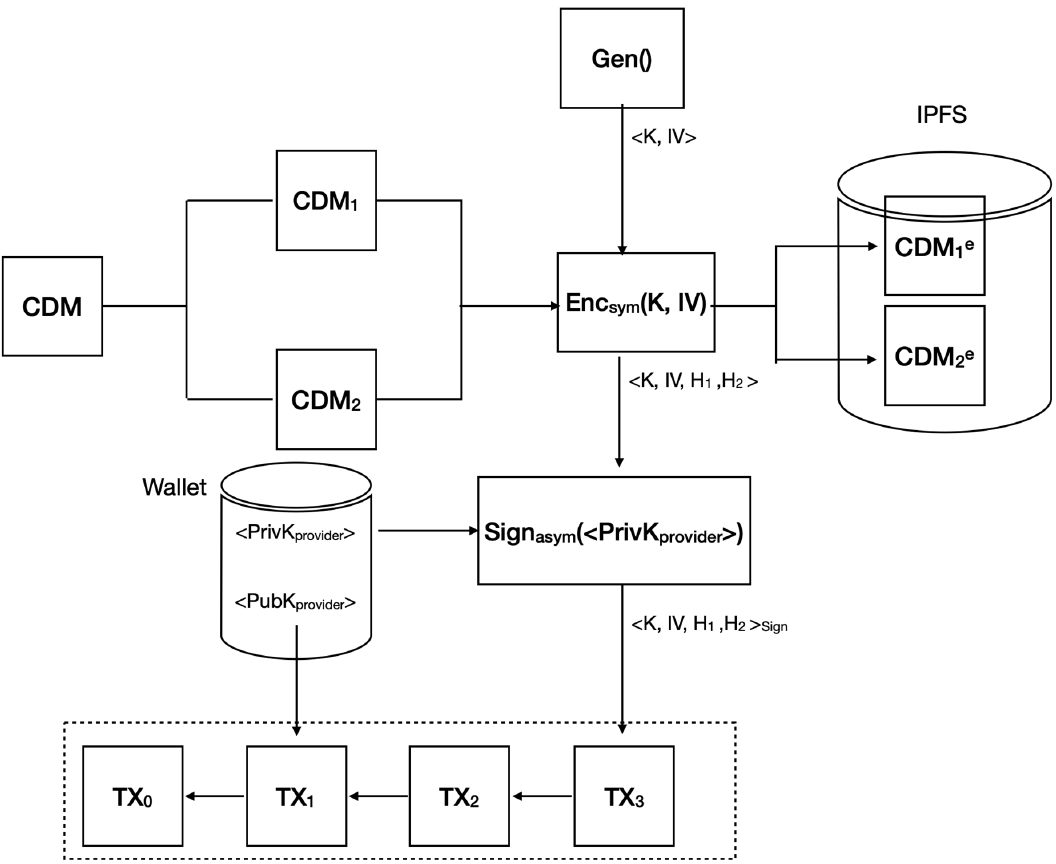
Figure 11. The overall process for building a secure CDM in SC-Blockchain.